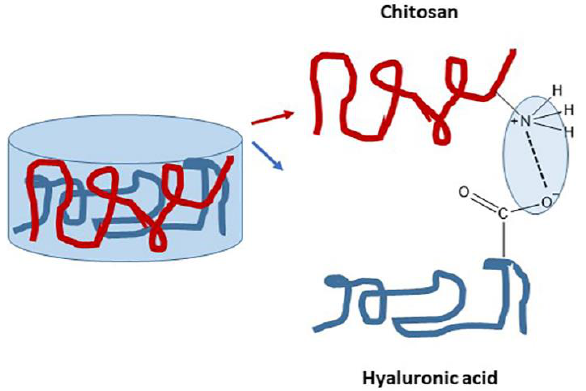
Figure 15. Electrostatic interactions between chitosan and hyaluronic acid [51].